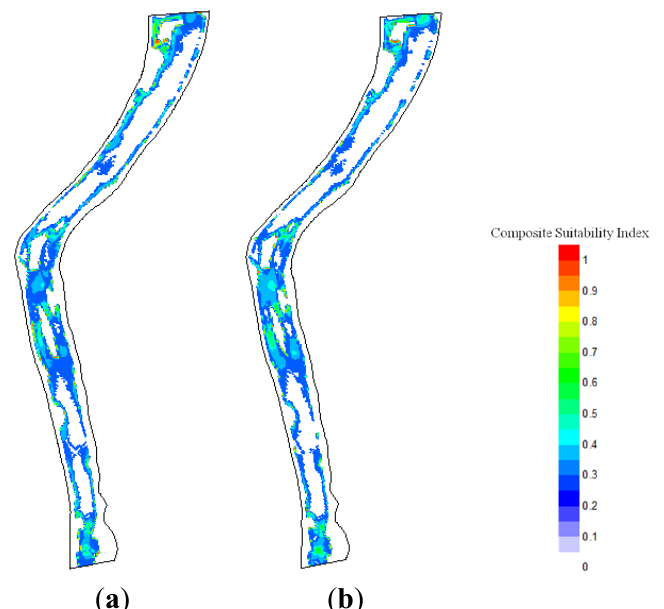
Figure 9. CSI distribution for Zacco platypus computed with GHSCs ( a ) with GHSC; ( b ) with improved